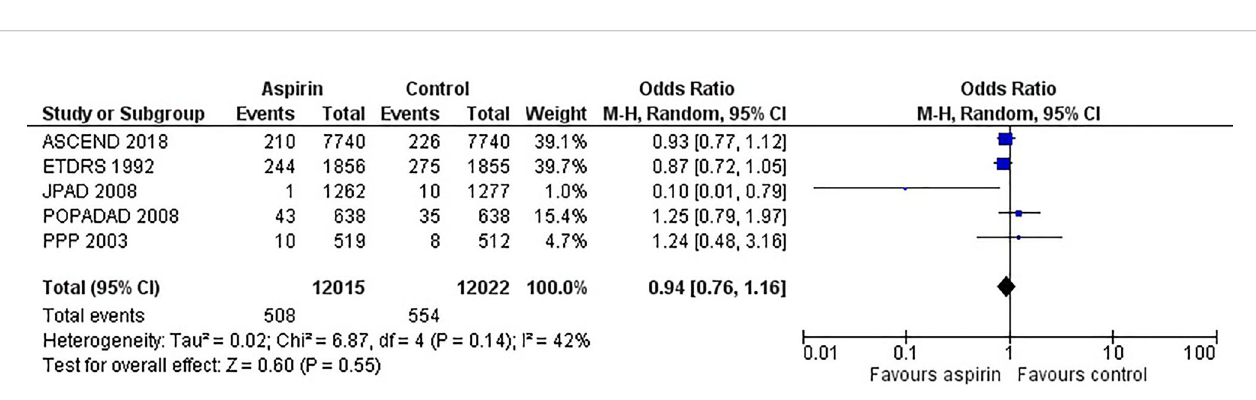
FIGURE 2 | Forest plot for the outcome of all-cause mortality using a random-effects model. Odds ratios and 95% con fi dence intervals are shown. Control: placebo or no treatment.